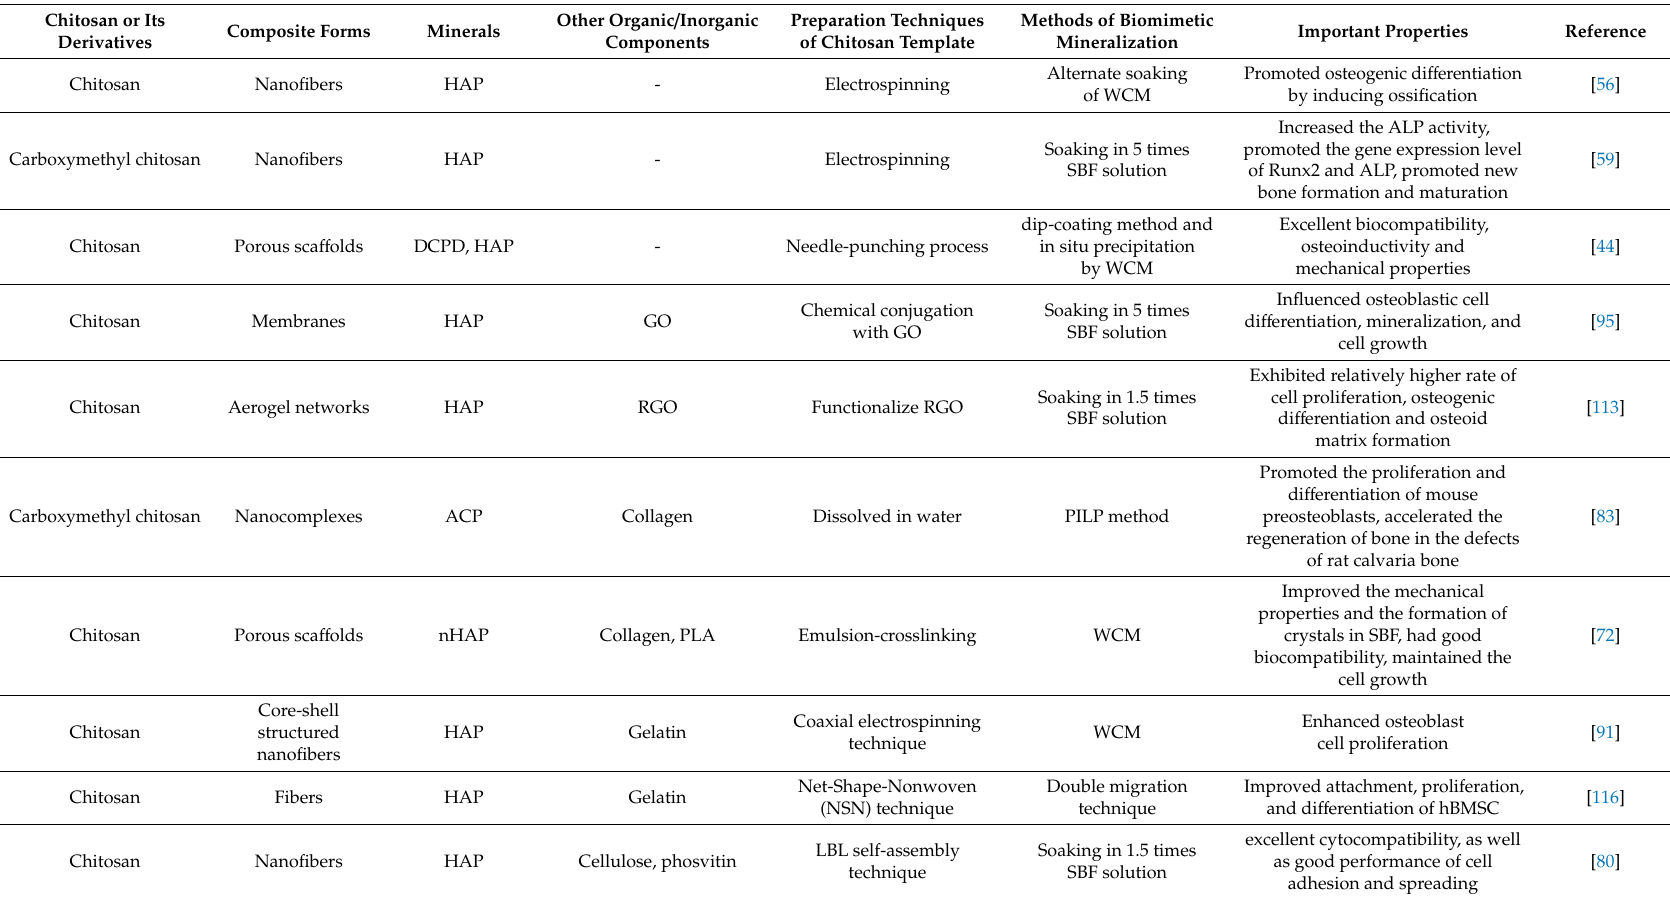
Table 1. Applications of chitosan-based biomimetically mineralized composite materials in bone tissue